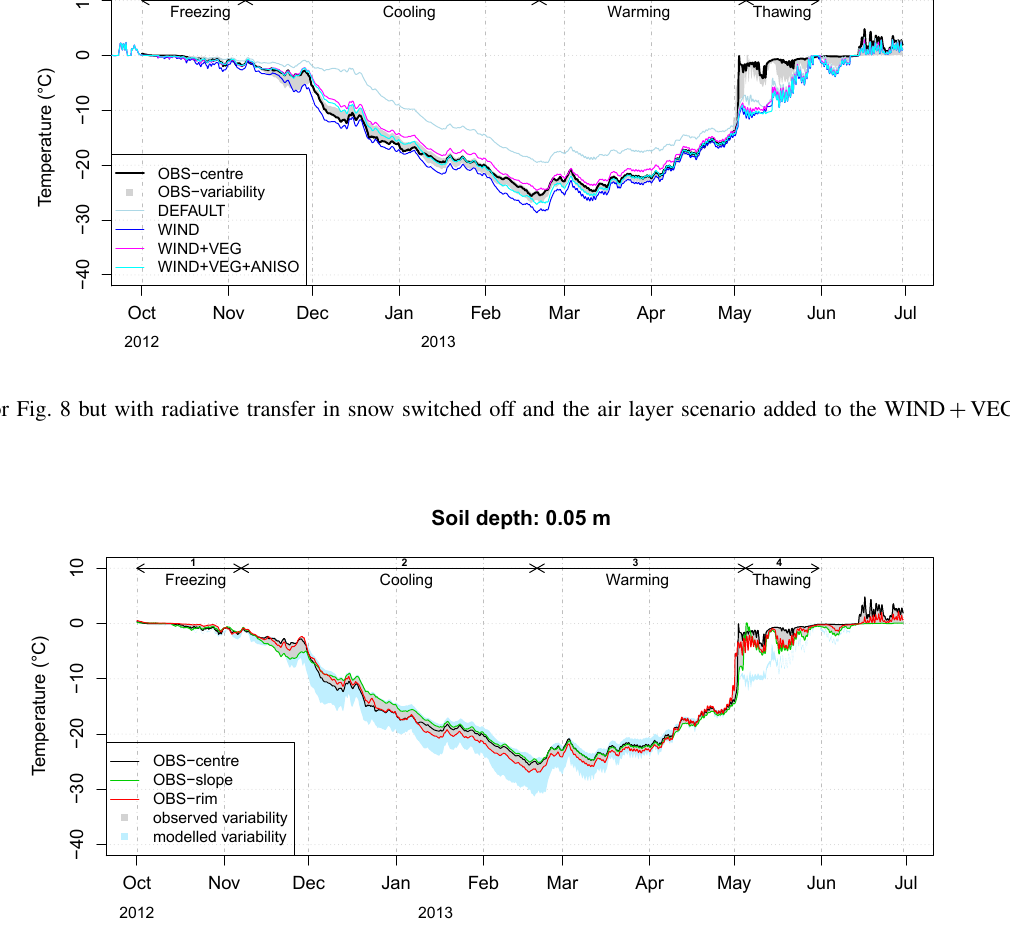
Figure 10. Simulated and observed soil temperature variability ( ◦ C) at 5cm in depth. Observed soil temperatures at rim, centre, and slope locations in the reference polygon are